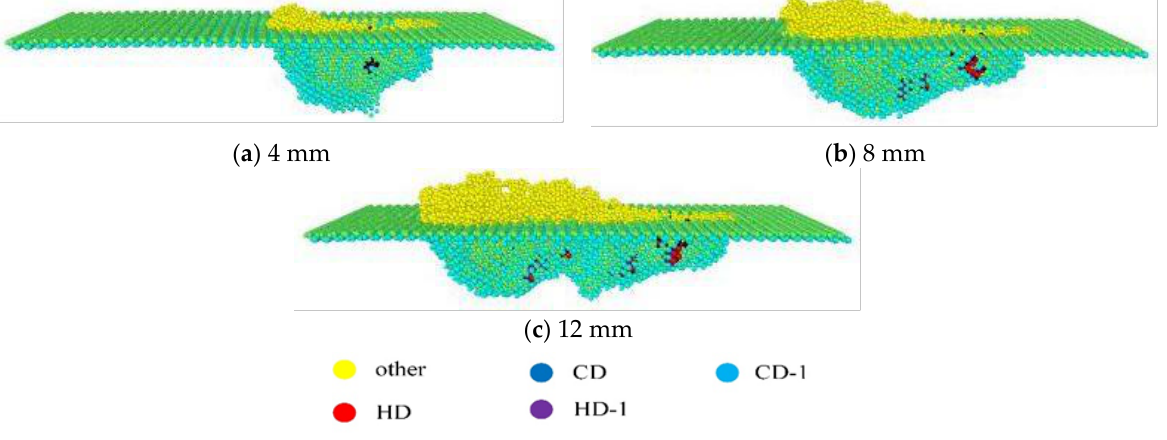
Figure 4. Atomic structure with different scratch lengths.